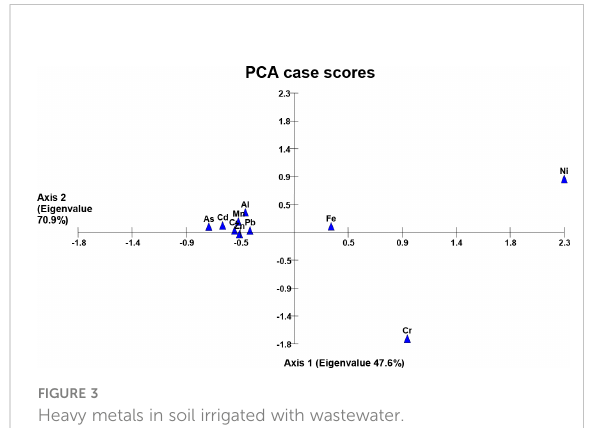
FIGURE 3 Heavy metals in soil irrigated with